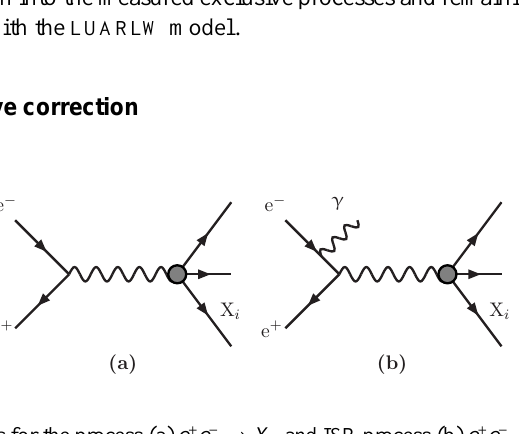
Figure 1. Feynman diagrams for the process (a) e + e −